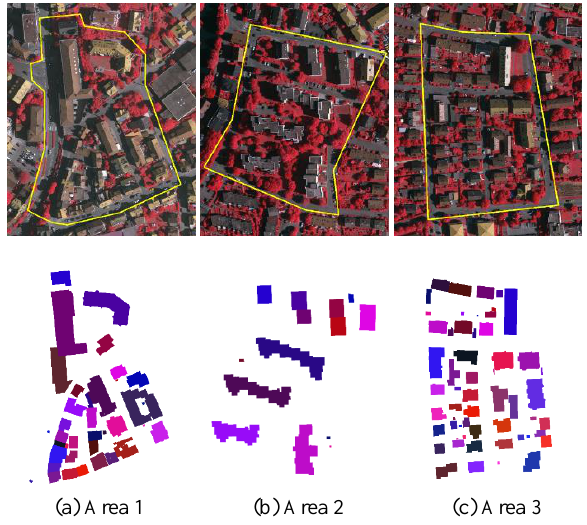
Figure 6. The experimental datasets and their corresponding ground truths